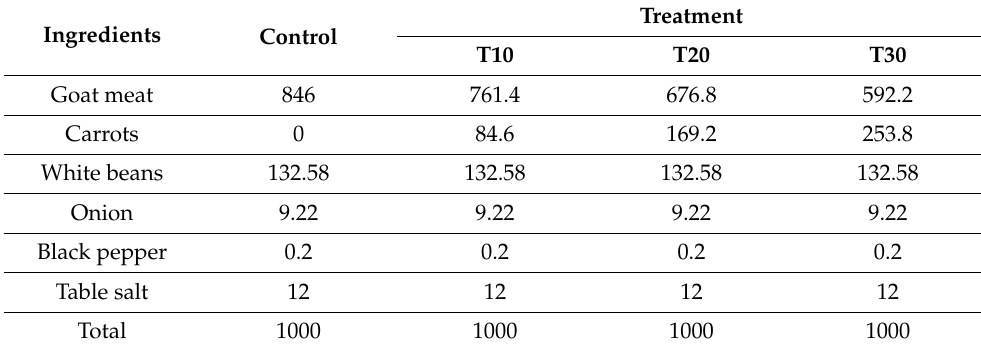
Table 1. Composition of canned meat with different carrot content